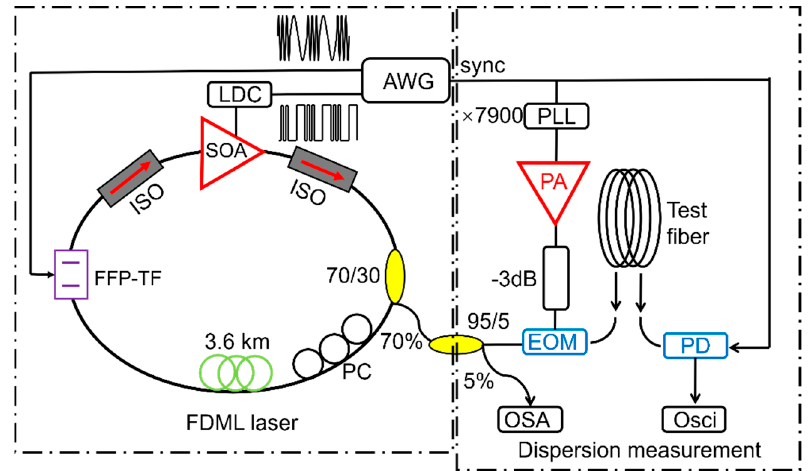
Figure 20. Schematic of the experimental setup to measure the DMGD in a few-mode fiber. Adapted with permission from Ref. [149].